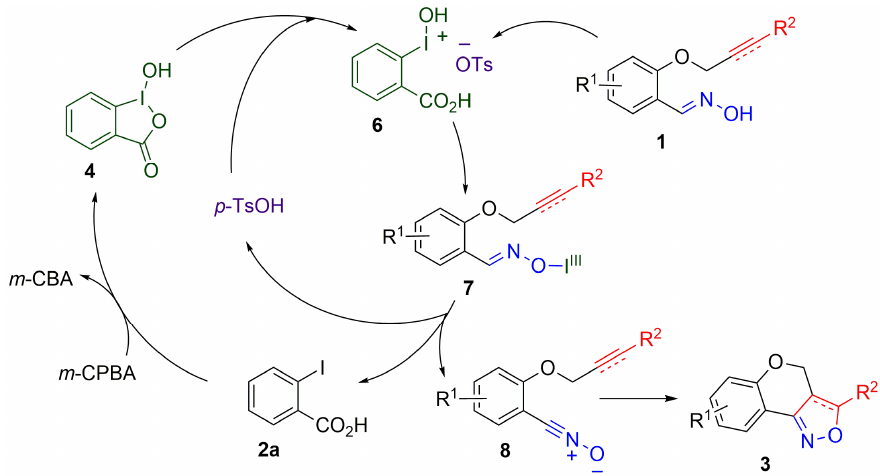
Figure 4. Proposed reaction mechanism.